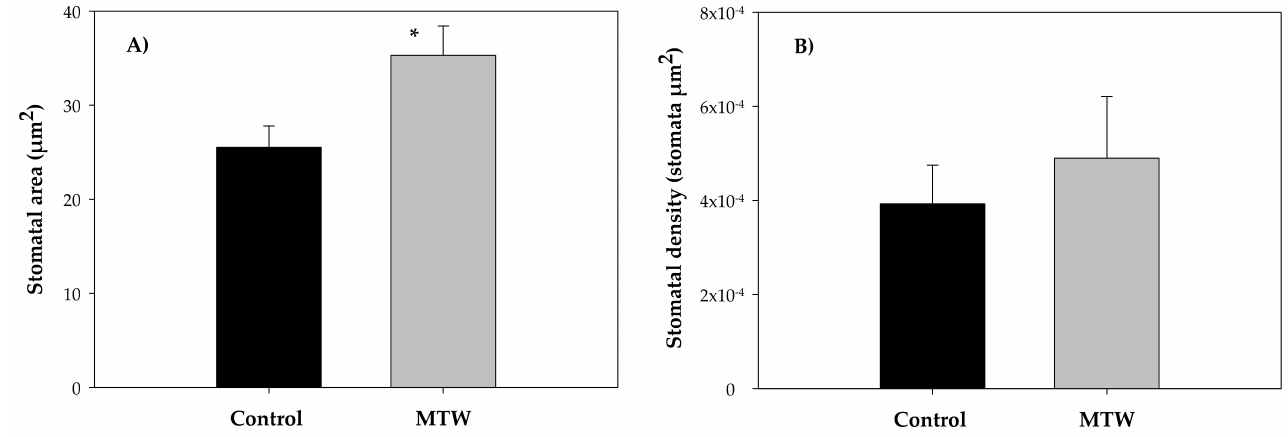
Figure 2. Mean values of stomatal area ( A ) and stomatal density ( B ) in Phaseolus vulgaris L. plants grown with magnetically treated water. * indicates statistically significant differences ( p < 0.05). Control: plants grown without magnetically treated water, MTW: plants grown with magnetically treated water under a static magnetic field between 100 and 160 mT.